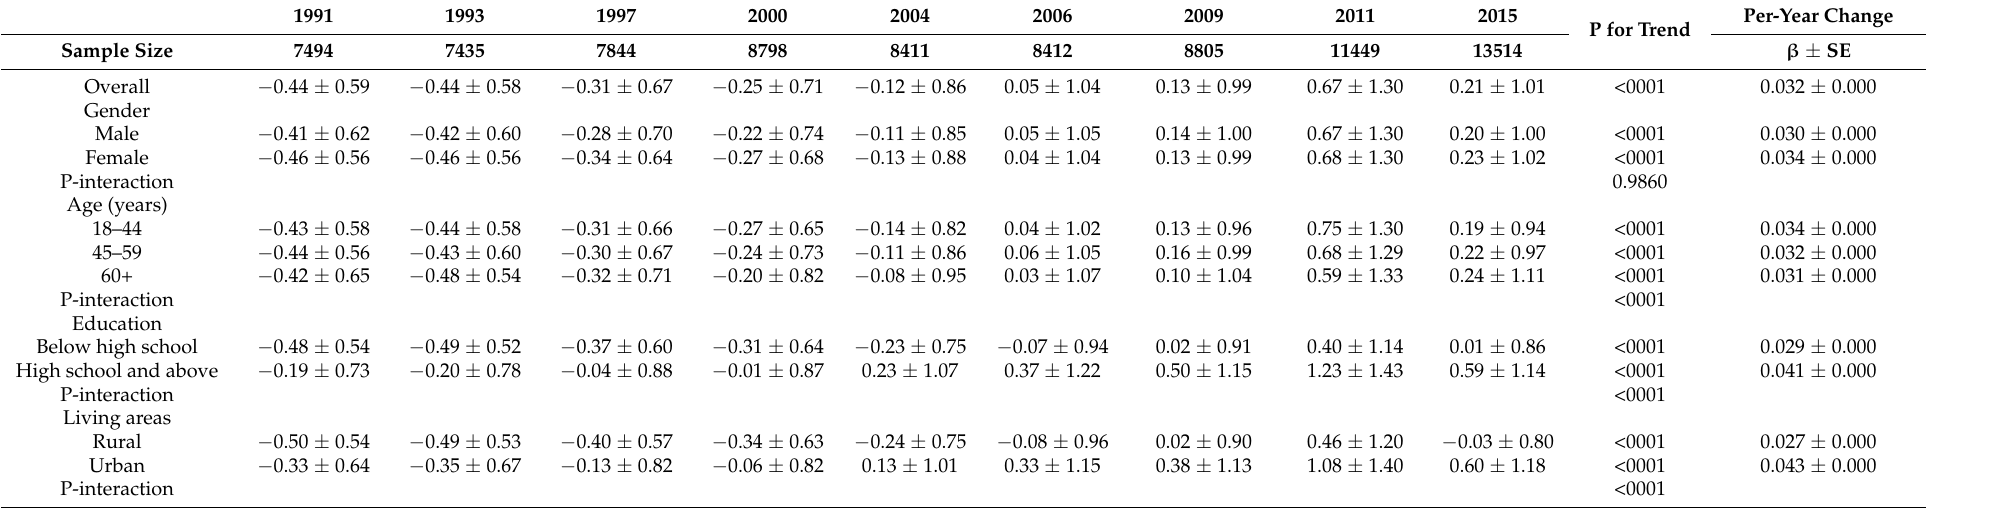
Table 4. Trends for the modern pattern score among Chinese adults from 1991 to